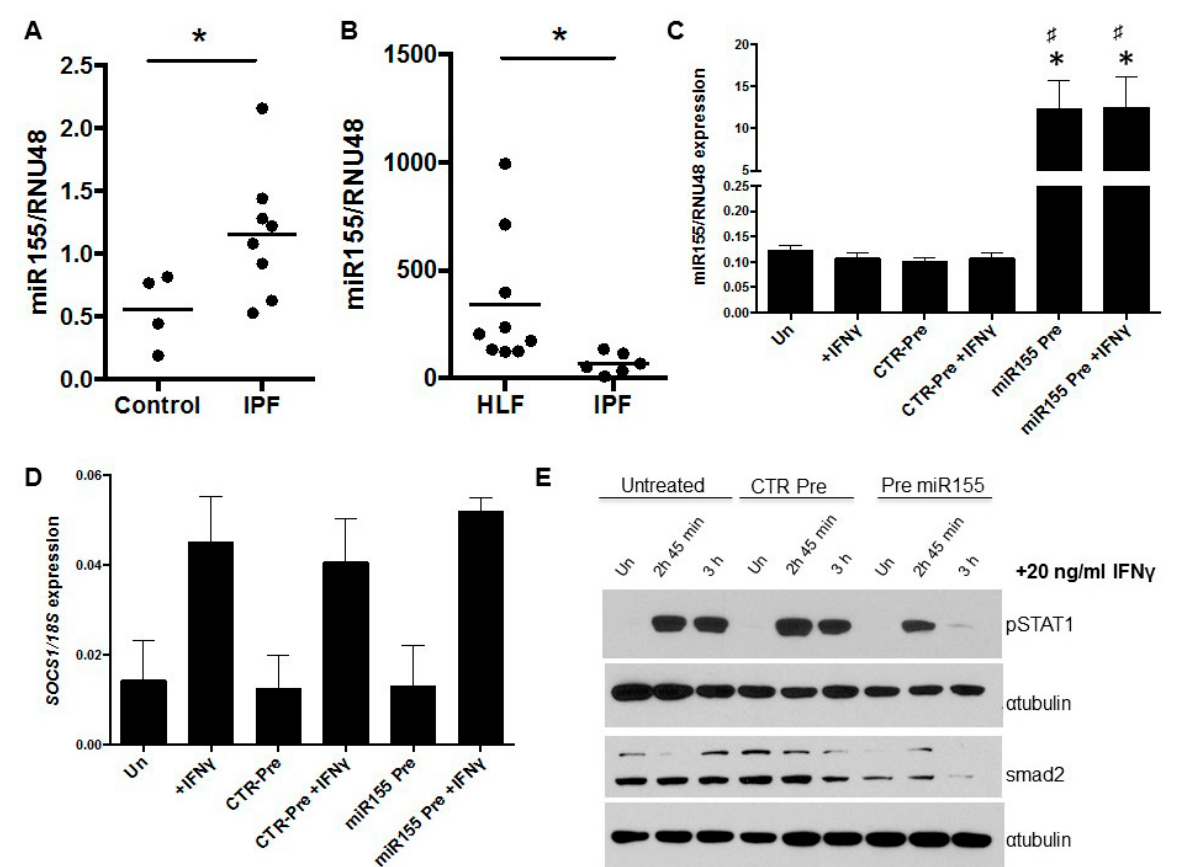
Figure 3. miR155 is altered in lung fibroblasts but does not regulate SOCS1 function. miR155 levels were measured in cDNA generated from ( A ) FFPE lung tissue extracts and ( B ) lung fibroblasts cultures. miR155 levels (normalized to RNU48) are elevated in the lungs of patients with IPF ( n = 8) compared to control lung tissue ( n = 4) p = 0.0485 but are significantly reduced in IPF fibroblasts ( n = 6) compared to control lung fibroblasts ( n = 9), p = 0.0028. ( C ) miR155 levels were increased in cultures of CCD-19Lu fibroblasts using a precursor to miR155 (pre-miR155). * p < 0.05 compared to un-transfected controls, # p < 0.05 compared to CTR pre-miR transfected cells, n ≥ 3). ( D ) High levels of miR155 did not alter basal levels of SOCS1 mRNA or the capacity for IFN γ to induce SOCS1 mRNA. ( E ) Western blot analysis revealed reduced phosphorylated STAT1 and SMAD2 levels in cells transfected with the pre-miR155. Alpha-tubulin was used as a control for protein loading.